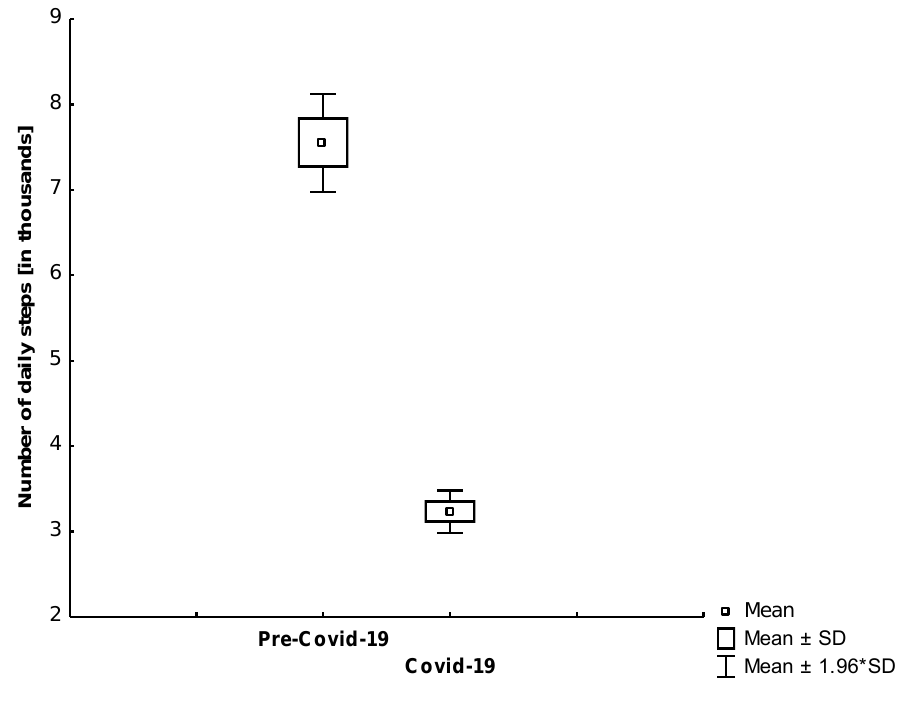
Figure 2. A comparison of the number of daily steps in the analyzed periods ( p < 0.001).